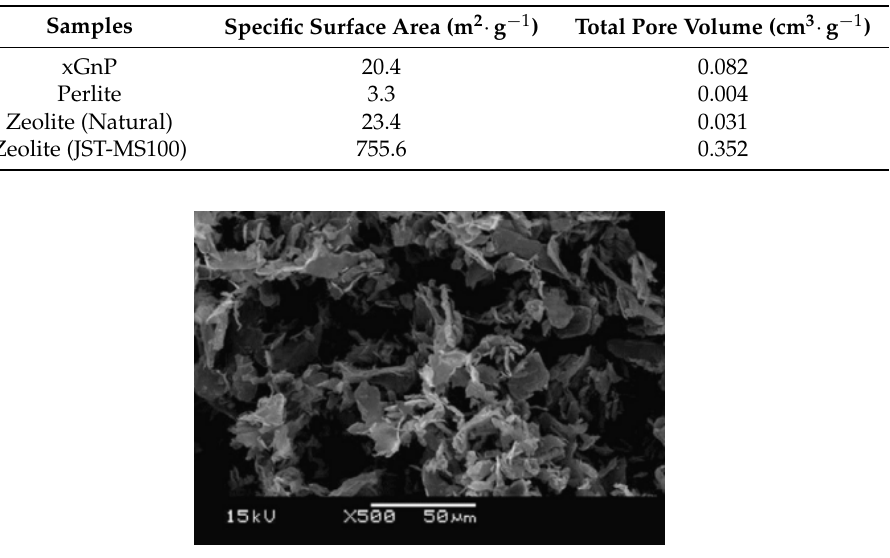
Figure 1. Scanning electron microscop (SEM) images of Exfoliated graphite nanoplatelets (xGnP).